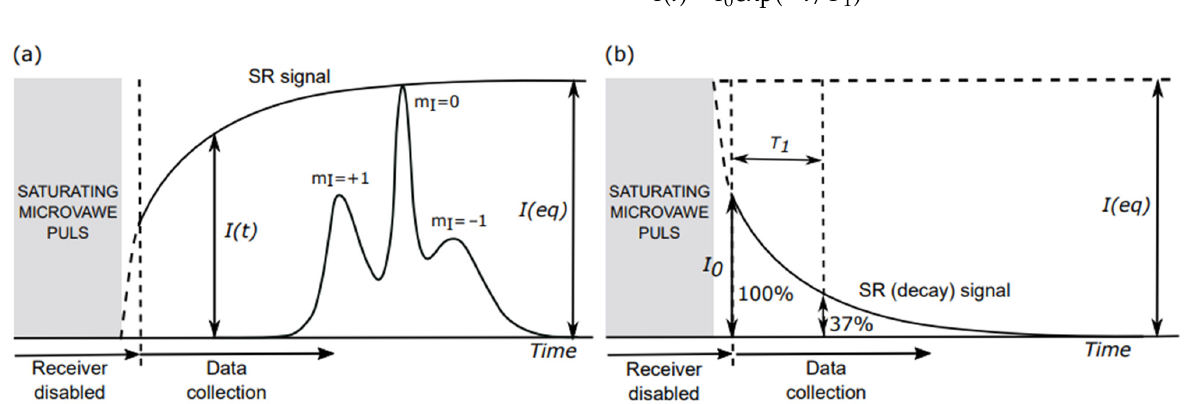
Figure 2. ( a ) The schematic illustration of the SR EPR experiment. The saturating high microwave power pump pulse (located at the field position of the central line (m I = 0) of the spin-label absorption spectrum) of the electron spin system. If pump power is high enough, the amplitude of the signal decreases to zero (this is the case described in the Figure). The recovery signal to thermodynamic equilibrium is recorded at the same field position with a weak observing microwave power. The time of the “recovery disabled” is needed to protect the detector. The recovery to the equilibrium state is